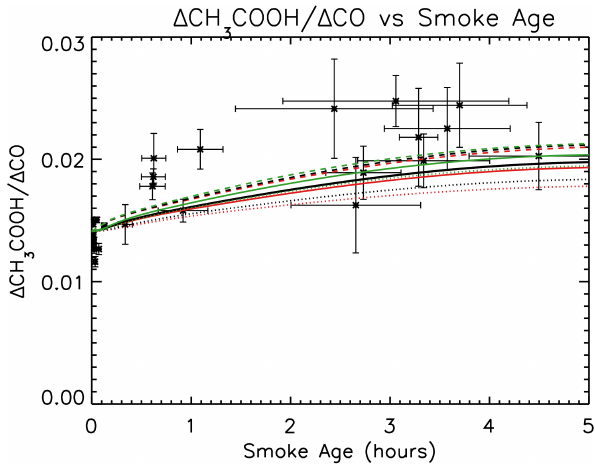
Figure 10. As in Fig. 8d, but for the “half fragmentation” SVOC mechanism (see Table 1) where the VOC fragment produced by fragmentation of the parent SVOC is assumed to become acetic acid (CH 3